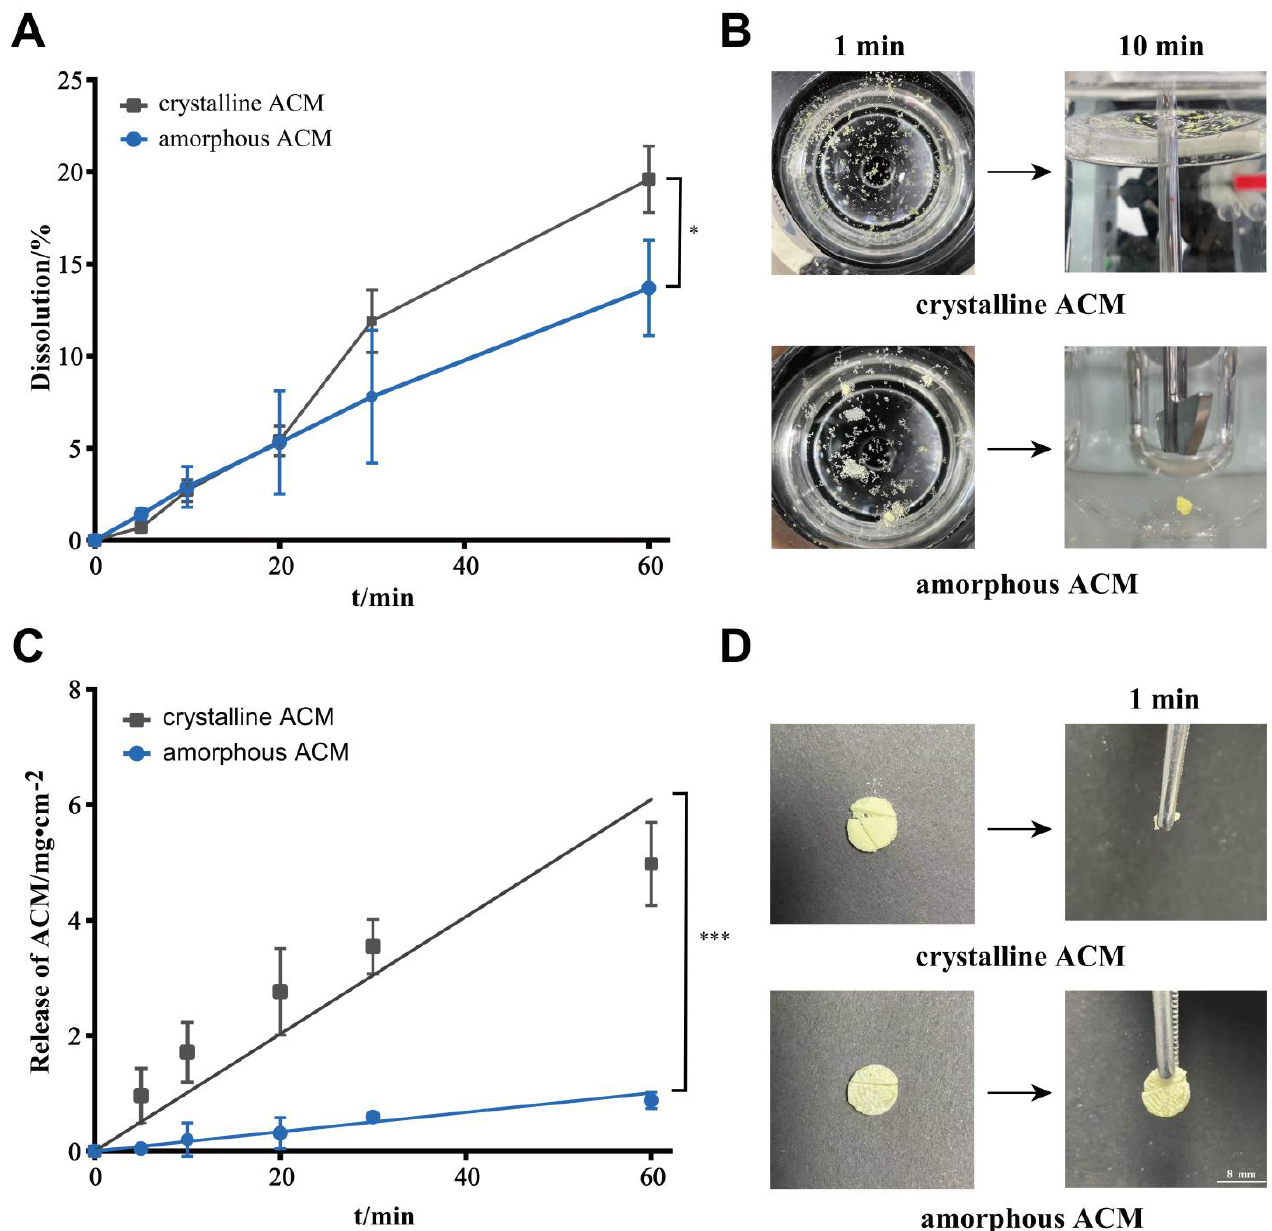
Figure 1. ( A ) Dissolution profiles and ( C ) IDR curves of crystalline ACM and amorphous ACM in water at 37 °C. Results are expressed as the mean ± SD ( n = 3, * p < 0.05 and *** p < 0.001 vs. crystalline ACM). ( B ) Photographs of crystalline ACM and amorphous ACM in a glass vessel during dissolu- tion in water at 1 min (vertical viewing) and 10 min (horizontal viewing). ( D ) Photographs of crys- talline ACM and amorphous ACM after intrinsic dissolution in 2 min.